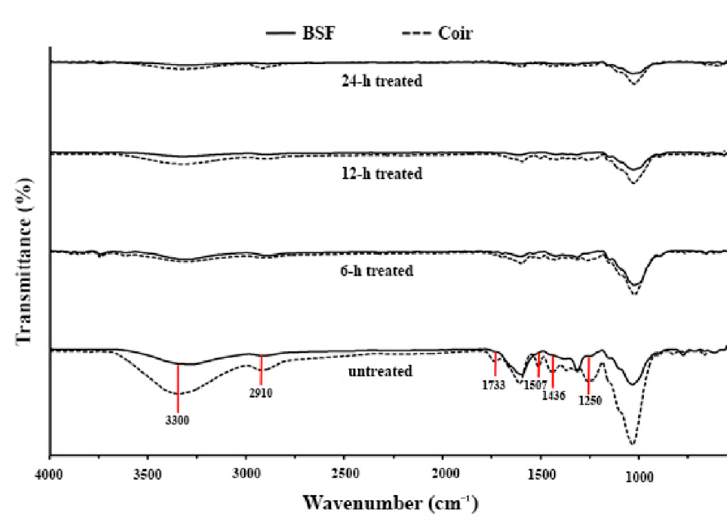
Figure 2. FTIR spectra of untreated and alkali-treated BSF and coir.